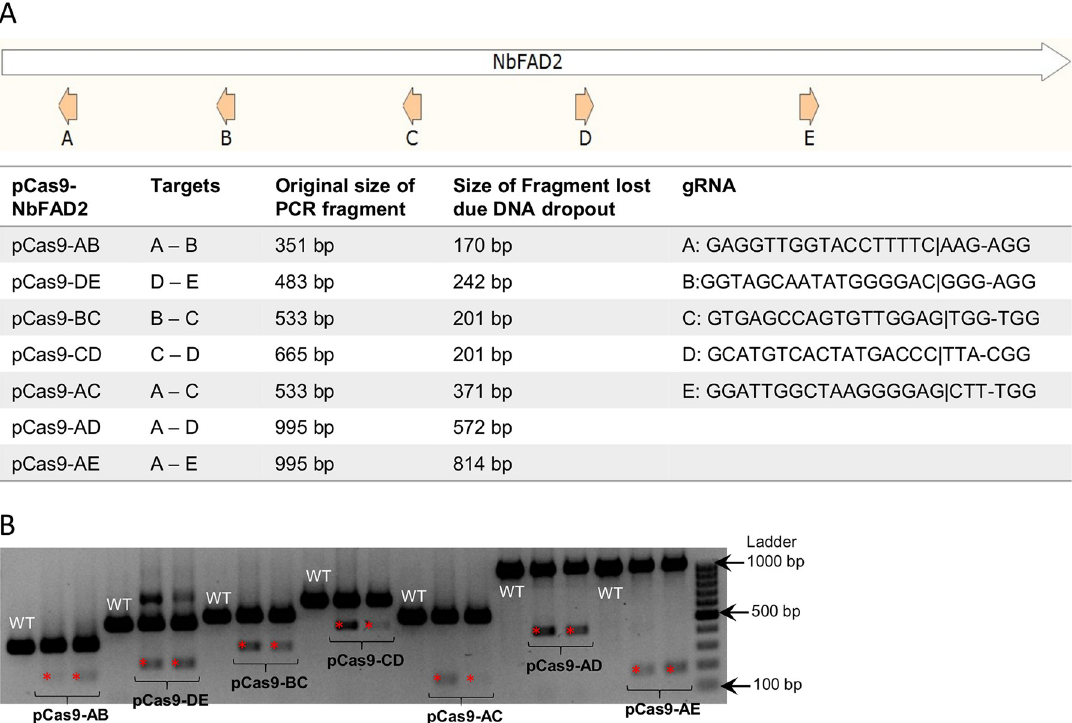
Fig 2. Editing efficiency of NbFAD2 with combinations of gRNAs targeting various sites of the gene. (A) Schematic of NbFAD2 with annotated five gRNAs used for editing. The table summarises various combinations of gRNAs used for agro-infiltrations, the expected sizes of PCR fragments before editing, the distance between two gRNAs resulting in dropout of DNA and the sequence of the gRNAs. (B) Gel image of PCR fragments from a wild-type uninfiltrated sample (WT) and two representative biological replicates of a total of five leaves infiltrated with each pCas9-NbFAD2 plasmid. The replicates shown are representative of the variation seen in leaf infiltration experiments. The bands denoted with a red asterisk on the gel image show evidence of dropout between two